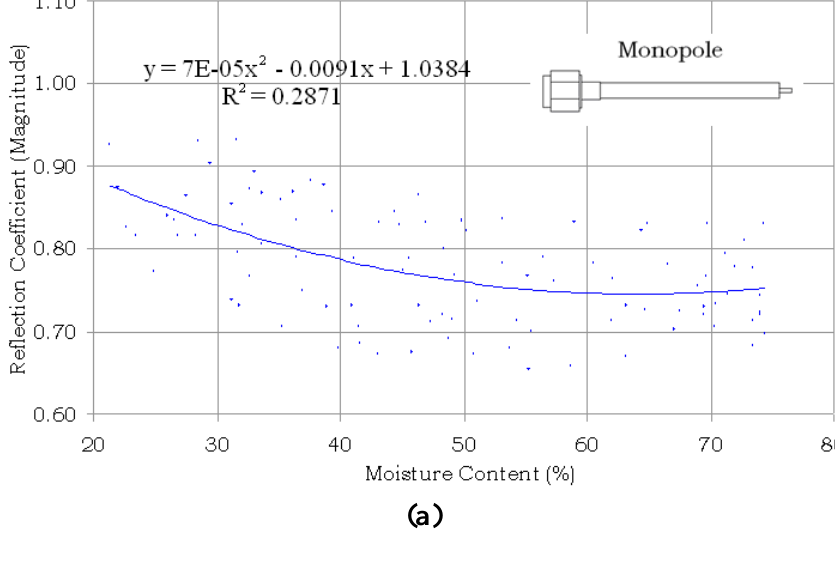
with moisture content using monopole 11